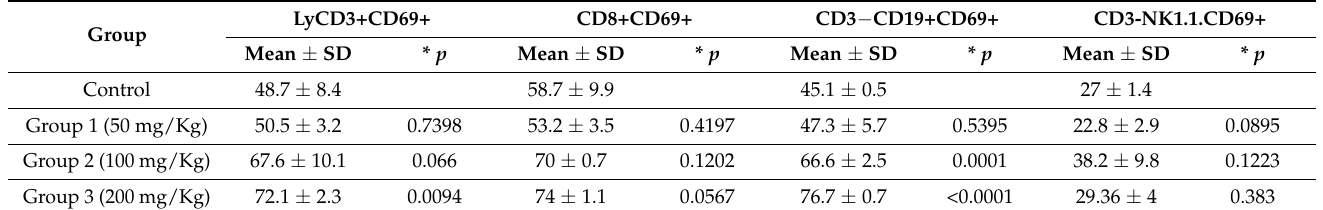
Figure 12. CD69 expression on lymphocytes in the groups that received ImunoBoost compared to the control group—stimulation with LPS; * = p value < 0.05. Table 13. The effect of administering ImunoBoost in three different concentrations on the expression of the CD69 marker on lymphocyte surfaces in mice—stimulation with conA; * p = p value.